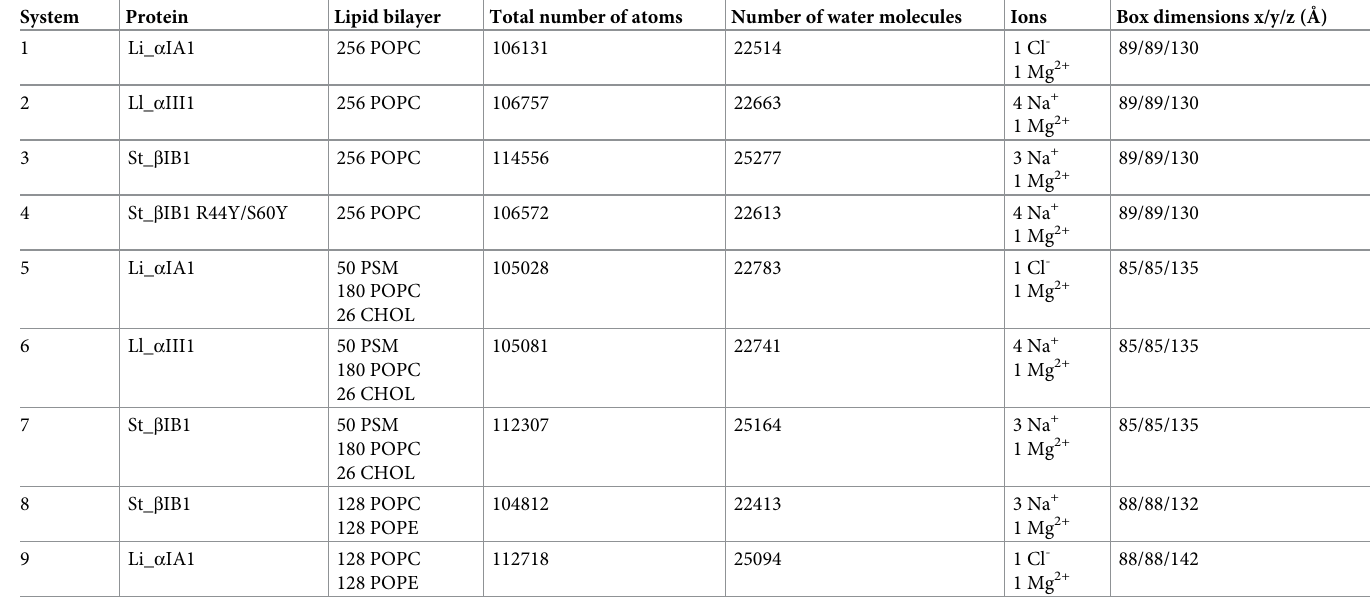
Table 1. Composition and size of the simulated systems. Each was simulated twice for 300 ns (production run), and one replica of the simulation of St_ β IB1 on the POPC bilayer was extended to one μ s. The raw trajectories are available at the NIRD Research Data archive (DOI: